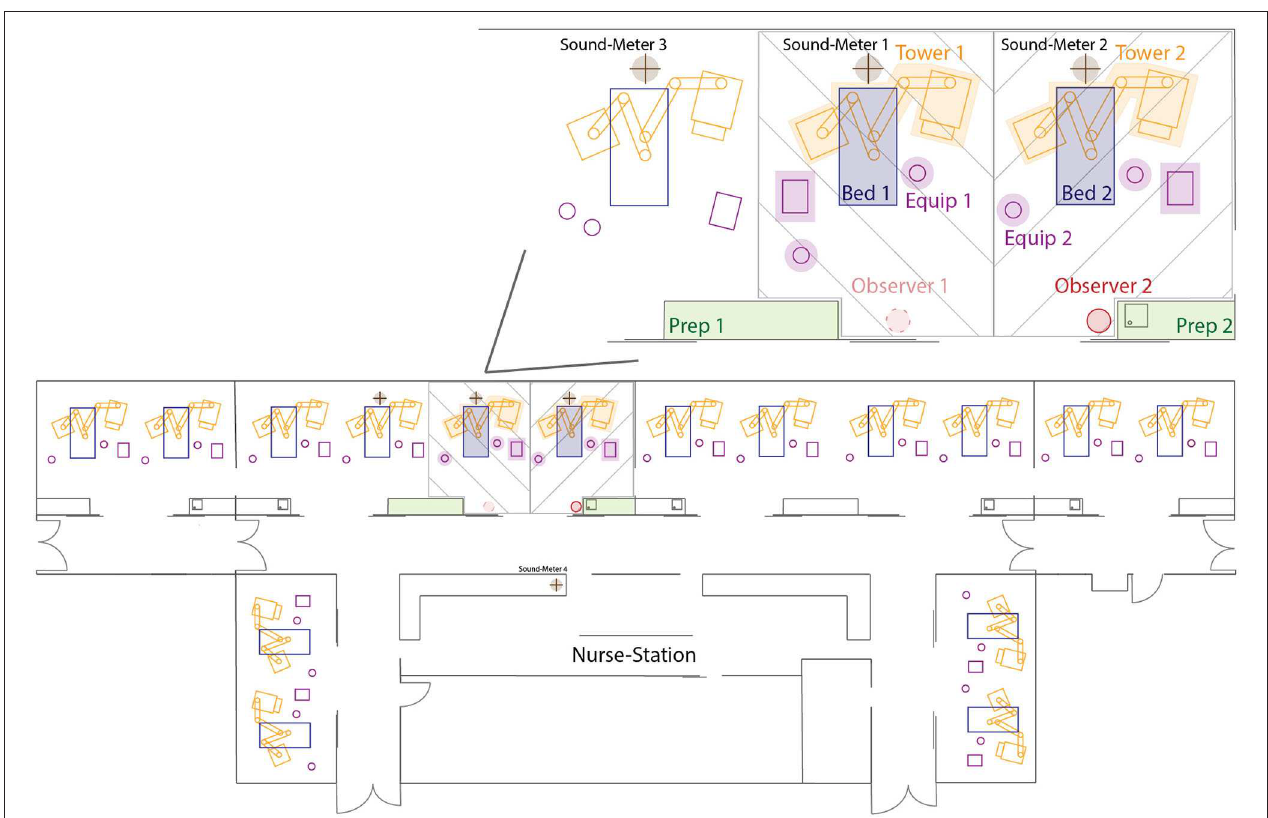
FIGURE 3 | Schematic display of the ICU ward on which the measurements took place. In the upper right, the two beds examined for the 24-h reference recording and inter-rater reliability are displayed in more detail. Observer 1 chair was only present while collecting data for the interrater reliability test. Green zones represent the preparation board, the pink items represent free-standing equipment in the room, orange zones represent the medical pendant on either side of the bed, the placement of the patient bed is depicted in dark blue, and the crossed brown circles represent the location of the sound level meters above the beds and at the nursing station. Shaded areas represent the two bed places examined for the reference recording and interrater reliability. Full list of abbreviations can be found in the Supplementary Table 1 .